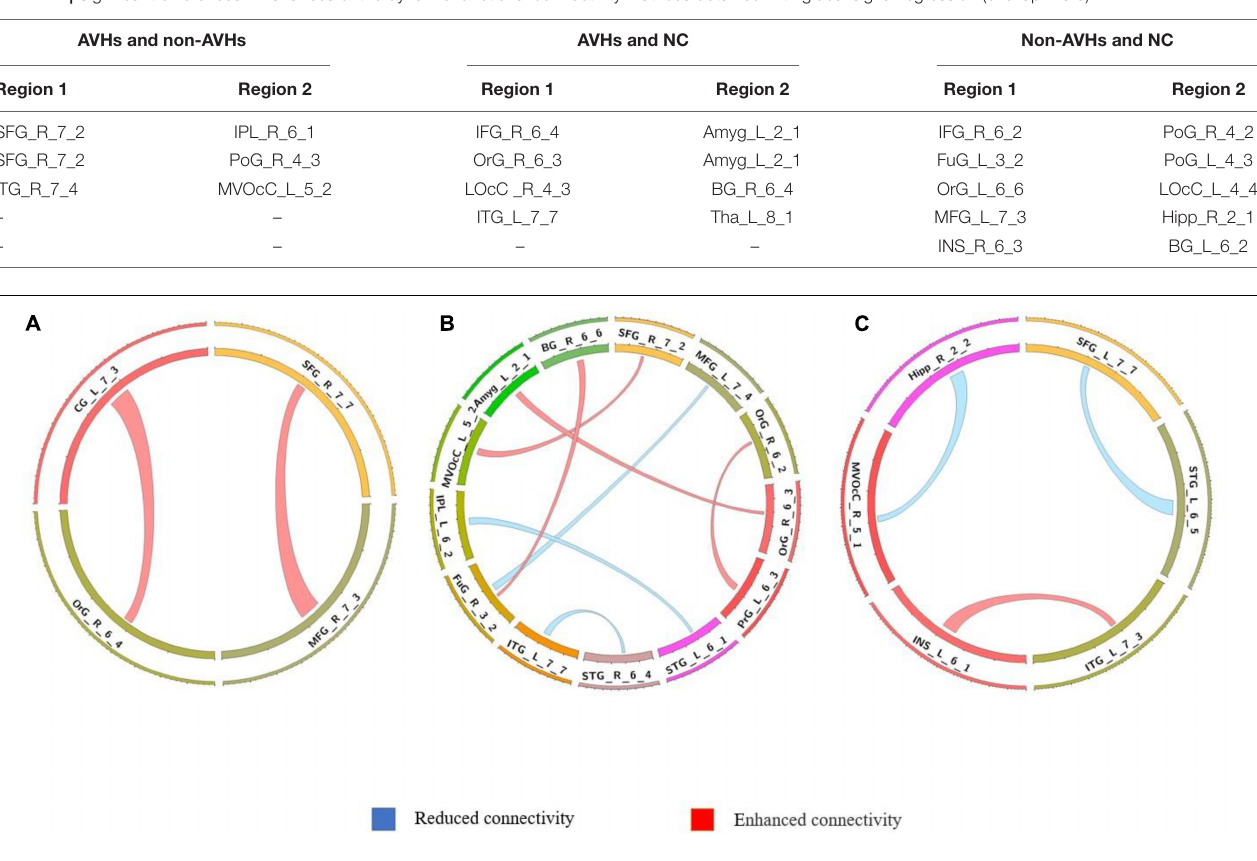
FIGURE 3 | Comparison of dynamic differences in functional connectivity without global signal regression (overlap = 0.6). (A) AVHs group compared with the non-AVHs group; (B) AVHs group compared with the NC group; (C) non-AVHs group compared with the NC group. Increased connectivity shown in red and decreased shown in